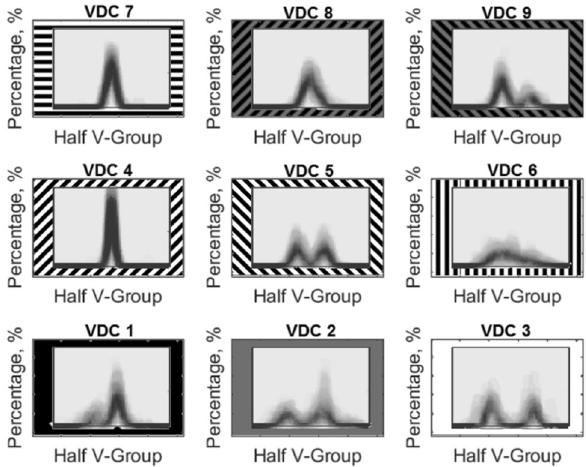
Fig. 4 Original regression blend fit and overall model statistics for both single coals and blends. Lines for y = x and y = x ± 5 are shown to aid comparison. For ease of interpretation, the figure displays only the results of blend fit, with the statistics reported developed on a model including both single coals and blends, excluding the VDC